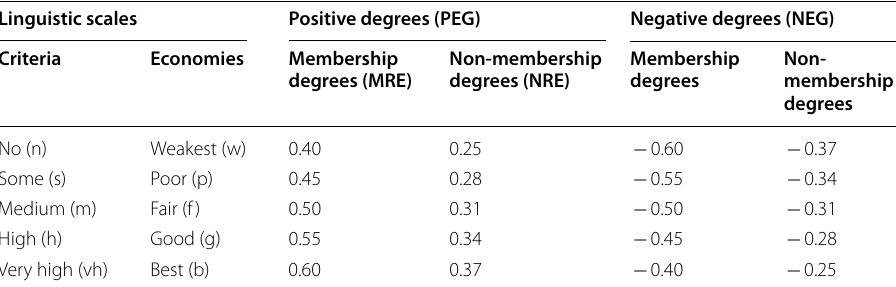
Table 10 Linguistic scales, golden cut-based positive and negative membership and non- membership